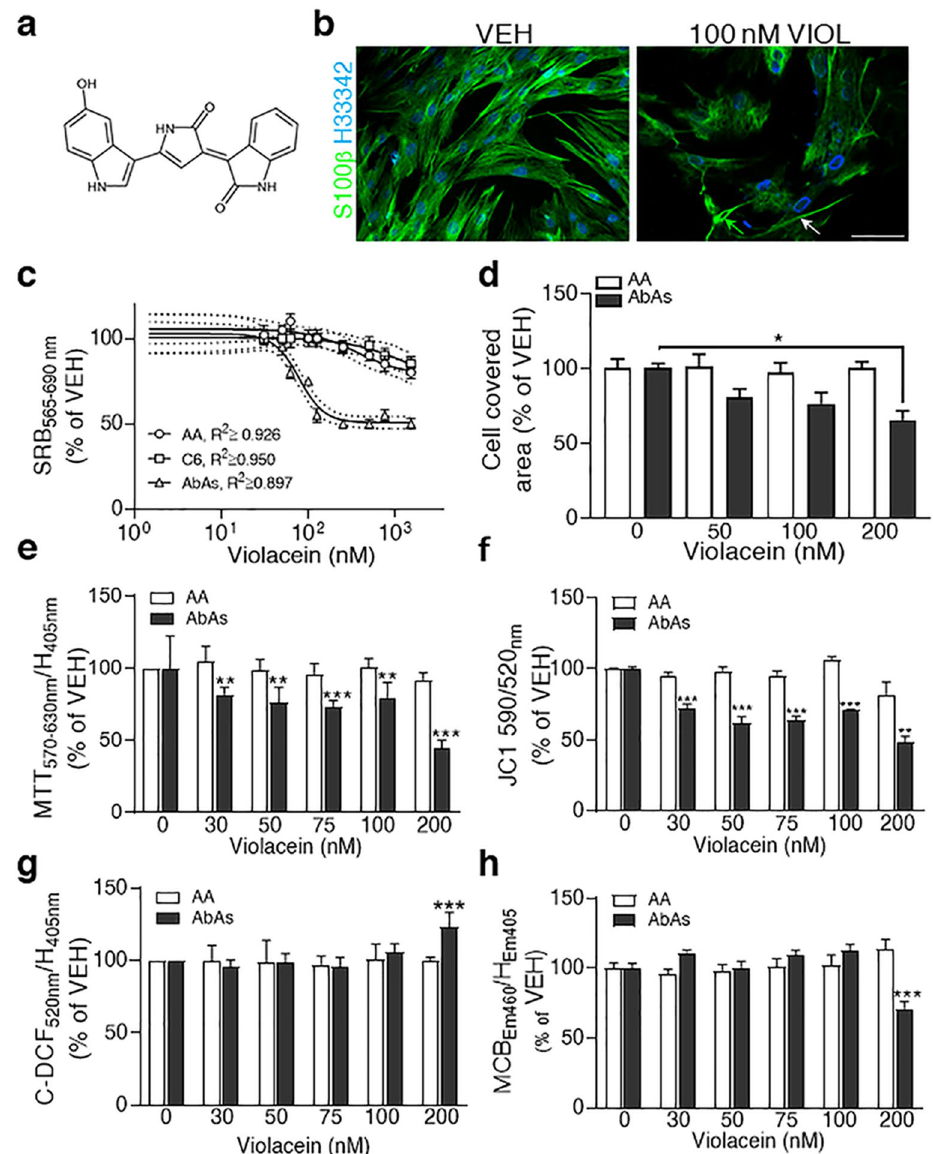
Figure 1. Violacein selectively controlled AbAs viability and decreased their antioxidant defenses. ( a ) Violacein molecular structure. ( b ) Representative confocal images of p6 AbAs showing a fibrilar S100β staining (green) upon a 24 h treatment with 0.25% DMSO (VEH) or 100 nM violacein. Violacein reduced cellular density and modified S100β appearance showing more condensed cytoskeleton (green arrow) or nuclear envelope and altered substrate adhesion (white arrow). Hoechst 33342 stained cell nuclei (blue). Calibration: 50 µm. ( c ) Concentration-inhibition curves in confluent p6 AbAs ( △ ), AA ( ○ ) or C6 ( □ ) cells cultures treated with 0–1500 nM violacein (24 h, sulforhodamine B (SRB) assay). Solid lines represent the best fittings whereas dotted ones indicate 95% confidence intervals. ( d ) Violacein effects on AA and p6 AbAs migration assessed by percent of cell covered area upon 48 h of treatment with vehicle or 0–200 nM violacein. At 200 nM, violacein reduced AbAs migration when compared with vehicle (p = 0.0181). ( e ) Violacein inhibitory effects on AbAs mitochondrial NAD(P)H activity evaluated by MTT reduction related to Hoechst 33342 fluorescence. Reduction was found since 50 nM violacein compared with vehicle (p = 0.0334) or with AA submitted to the same concentration (p = 0.004). Hoechst 33342 was abbreviated as H. (f) Selective action of violacein on AbAs mitochondrial potential assessed with JC1. Decreases in AbAs were found at 30 nM (p = 0.0005) and higher concentrations. At 200 nM, violacein marginally decreased AA mitochondrial potential (p = 0.057). ( g ) Effects of violacein on levels of oxidative stress in AA and p6 AbAs assessed by carboxy-dichlorofluorescein (C-DCF) fluorescence and expressed as C-DCF/Hoechst 33342 fluorescence ratios related to vehicle. At 200 nM, violacein increased C-DCF relative emission in AbAs when compared with vehicle (p = 0.0047) or with AA (p = 0.001). ( h ) Effects of violacein on total glutathione levels were seen at 200 nM with reduced formation of glutathione- monochlorobimane (MCB) adducts in AbAs respect to the vehicle (p = 0.0007) but not in AA. Experiments and replicates appear in Table 1 for all of the figures. ( d – g ) symbols: □ : AA; ■ :